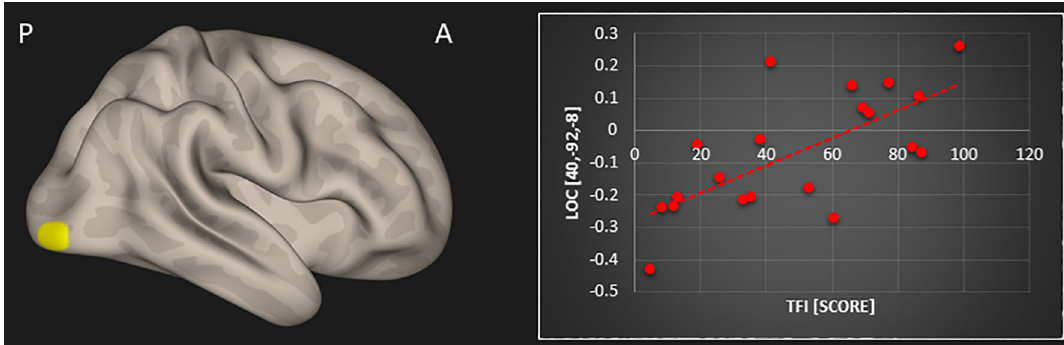
Figure 3. Significant association between TFI scores and resting-state functional connectivity of the precuneus with the right lateral occipital cortex (LOC) in tinnitus patients [p < 0.05; cluster-corrected threshold]. Significant brain areas were displayed on an inflated brain by CONN version 20b 31